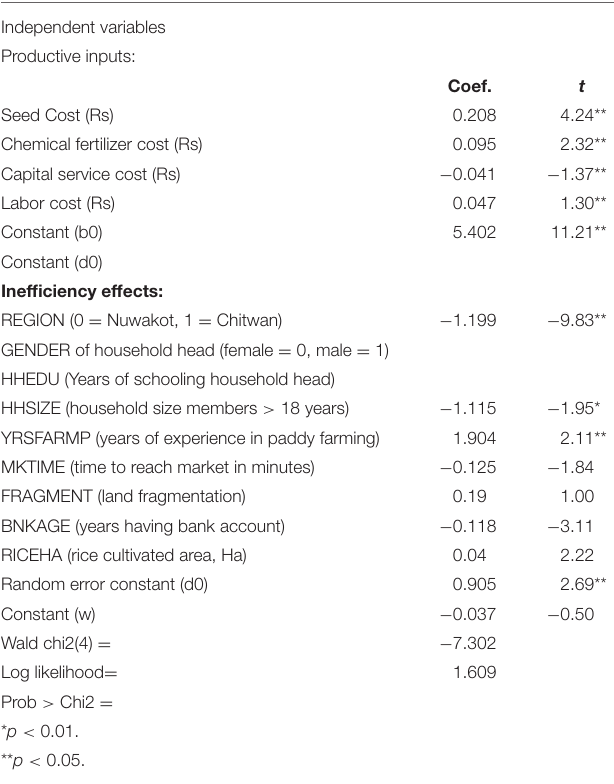
TABLE 11 | Stochastic frontier